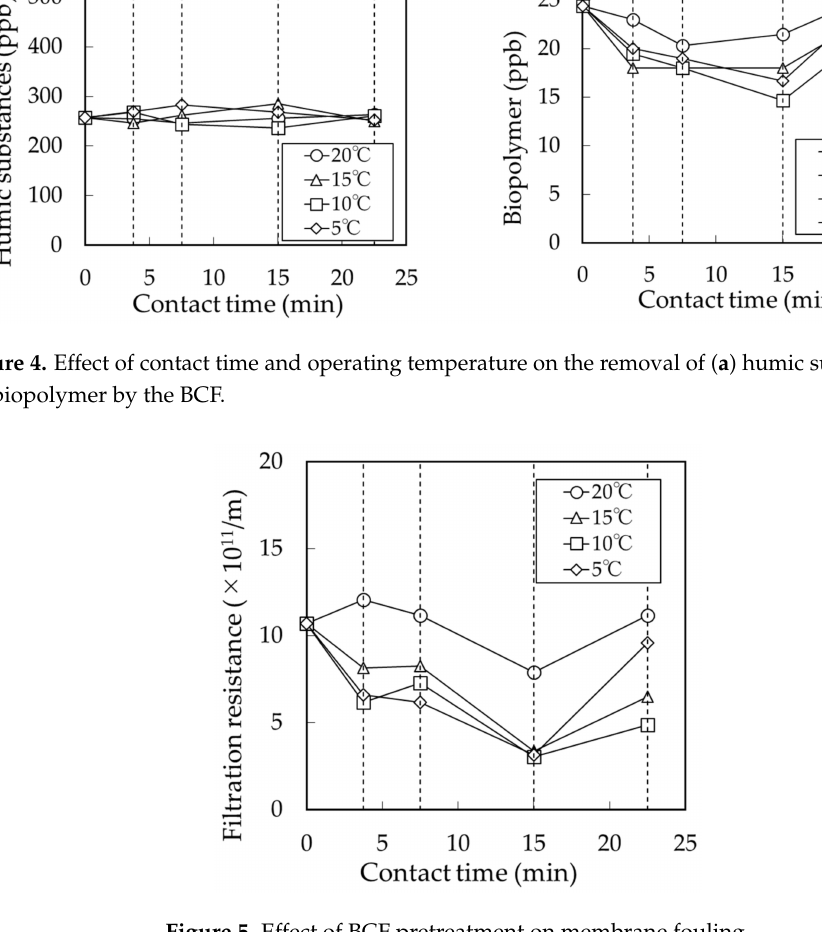
Figure 5. Effect of BCF pretreatment on membrane